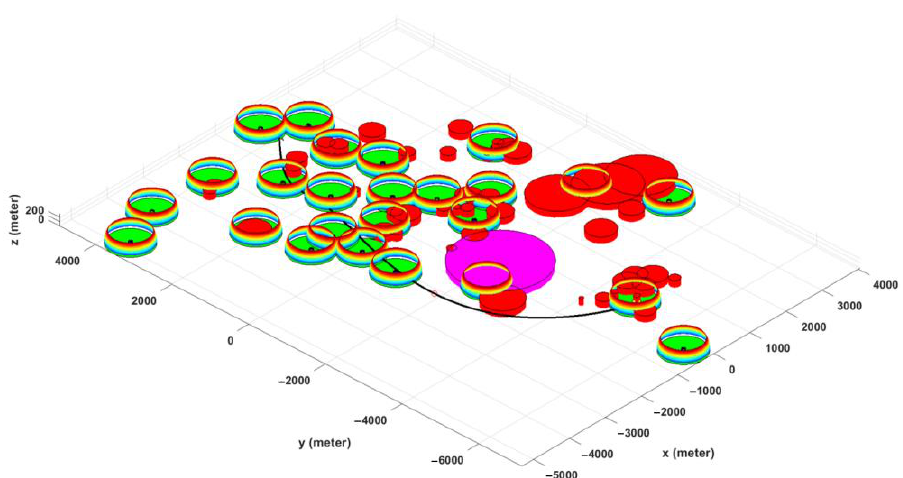
Figure 12. Simulation results of different optimization algorithms in Scenario III: ( a ) path planning results and ( b ) cost function value vs. the number of function evaluations.